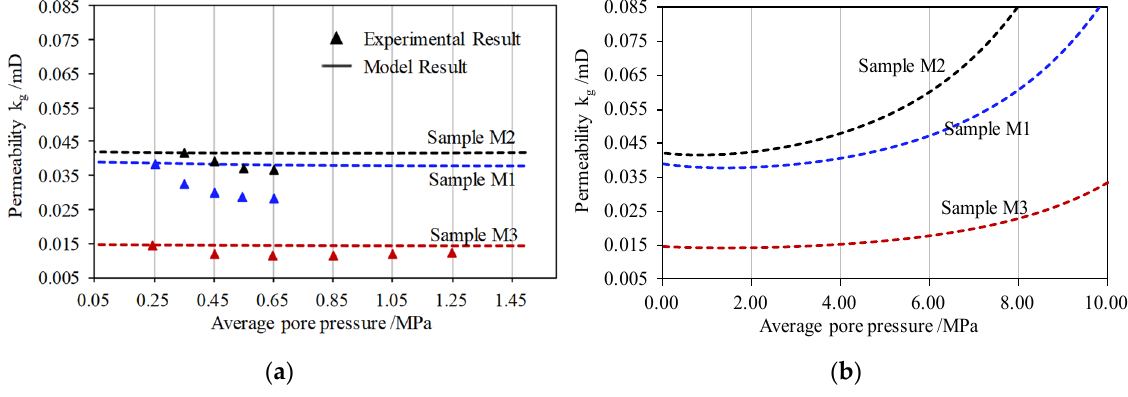
Figure 10. Permeability model calculation results without considering the gas slippage effect. ( a ) Fitting of the permeability model with the experimental data. ( b ) Permeability results for a wider pore pressure range.